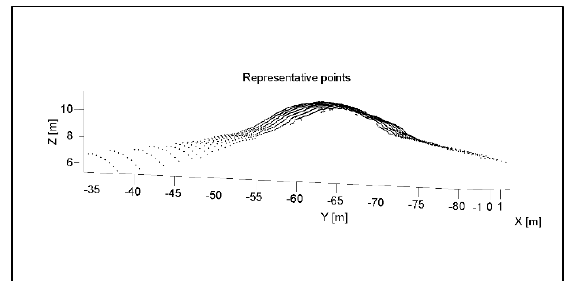
Figure 3. Estimated representative points on the top tunnel surface on Dec. 2 nd